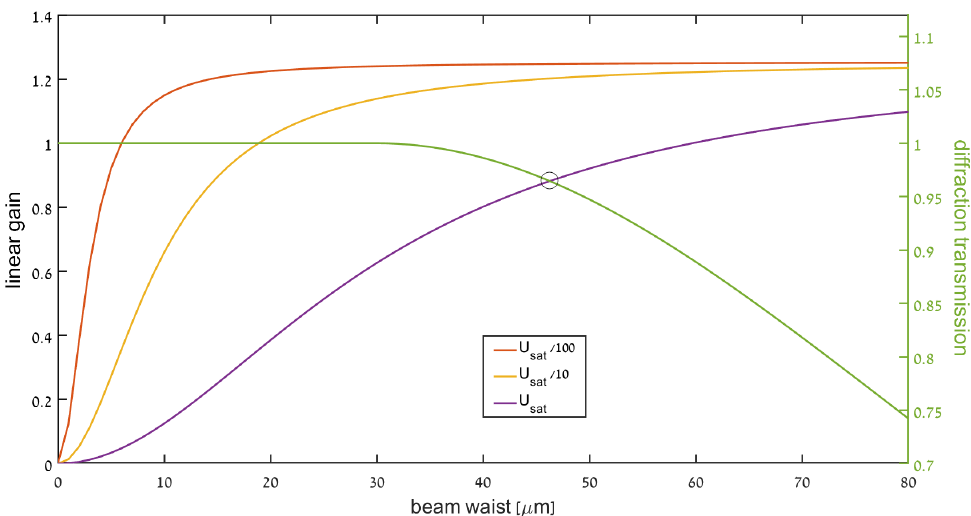
Figure 7. Modeling the diffraction losses. Left axis : gain as function of the beam waist for three pulse energies, U sat /100 (red), U sat /10 (yellow), U sat (purple). The saturated gain value depends on the beam waist because for narrow beams, the spatial overlap with the pump mode is only partial (see algorithm for exact dependence). Thus, as the pulse energy increases, gain saturation pushes the beam toward wider beam waists to fully extract the pump energy. Finally, however, diffraction losses come into effect, as shown in the right axis : Diffraction transmission (1-loss) as a function of beam waist (green curve). The beam waist at steady state would correspond to the maximal net gain, g · l D , which occurs near the equality point (marked by the black